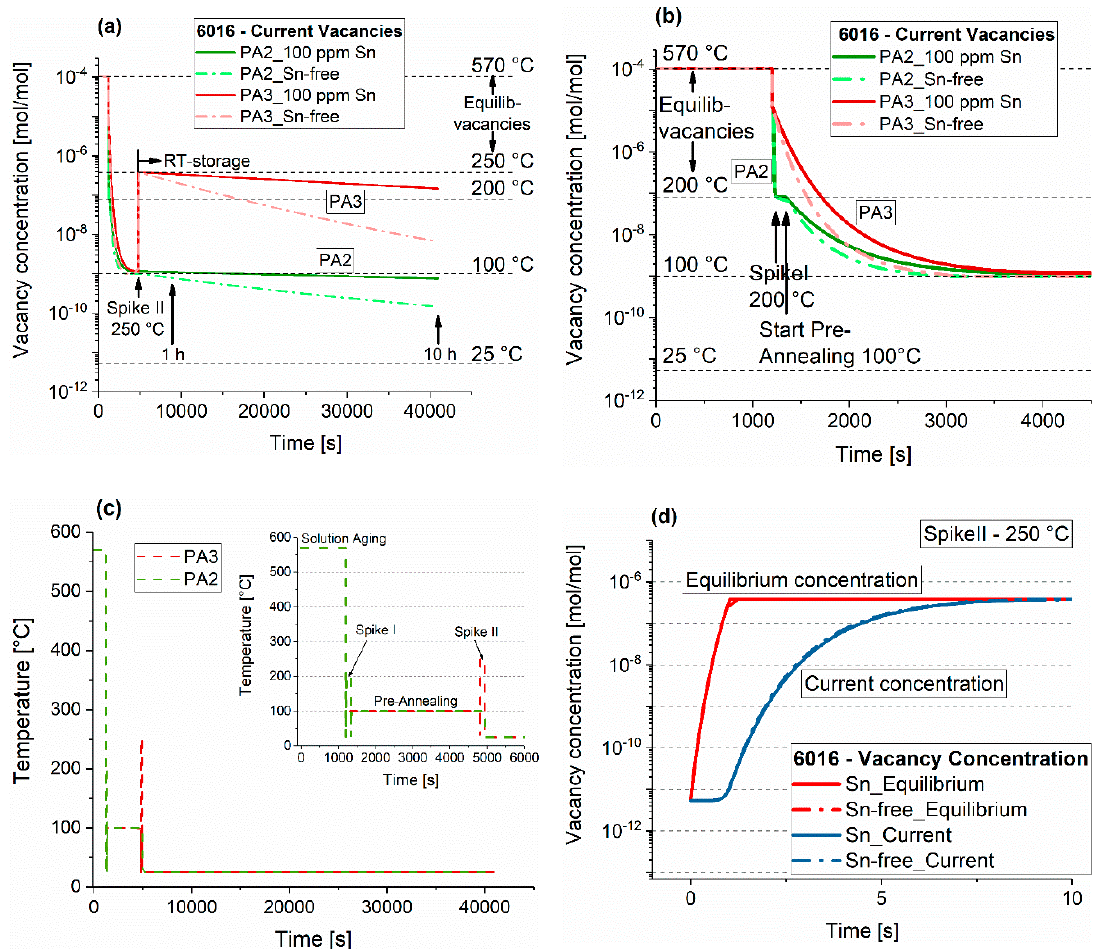
Figure 15. ( a ) Vacancy concentration during PA2 and PA3. The dashed horizontal lines represent the equilibrium concentrations at the respective temperatures. For better visibility, only one hour of pre-annealing at 100 ◦ C was applied and 120 s for both Spike I (200 ◦ C) and Spike II (250 ◦ C). ( b ) An excerpt of ( a ) for better visibility. ( PA2: Solution Aging → Quenching → Spike I (200 ◦ C, 120 s) → Pre-Annealing (100 ◦ C, 1 h) → RT. PA3: Solution Aging → Quenching → Pre-Annealing (100 ◦ C, 1 h) → Spike II (250 ◦ C, 120 s) → RT) ( c ) Detailed depiction of the heat treatment PA2 and PA3, which was used for vacancy calculations. ( d ) Vacancy generation upon heating from 25 to 250 ◦ C with and without the trapping e ff ect of Sn (heating rate 220 K / s). The dot-dashed lines mark the values of the Sn-free alloy. Calculated with MatCalc 6.00, using the FSAK vacancy annihilation model [27].